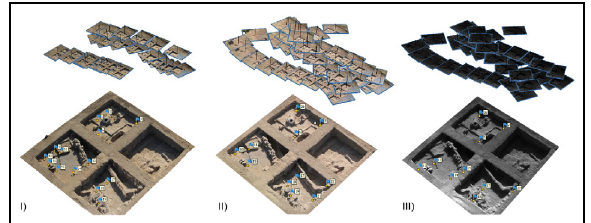
Figure 8 . Overview of the GCPs and the aerial image data after the image orientation (4/7/2019) in AgiSoft PhotoScan software of the 3 archaeological trenches: (I) DSLR Canon EOS 1200D, (II) Sequoia RGB Parrot and (III) Sequoia MultiSpectral Parrot.